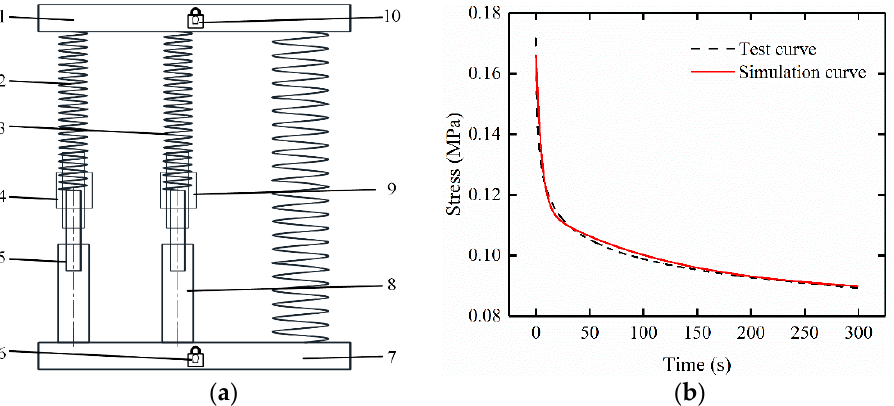
Figure 8. Stress relaxation virtual prototype model and test results: ( a ) Model: 1. upper pressure head 2. spring 1 3. spring 2 4. prismatic pair 1 5. damper 1 6. fixed constraint 1 7. lower pressure head 8. damper 2 9. prismatic pair 2 10. fixed constraint 2; ( b ) Curves comparison between